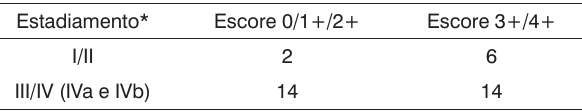
Tabela 3. Distribuição de escores segundo estágio tumoral para tumores MD.